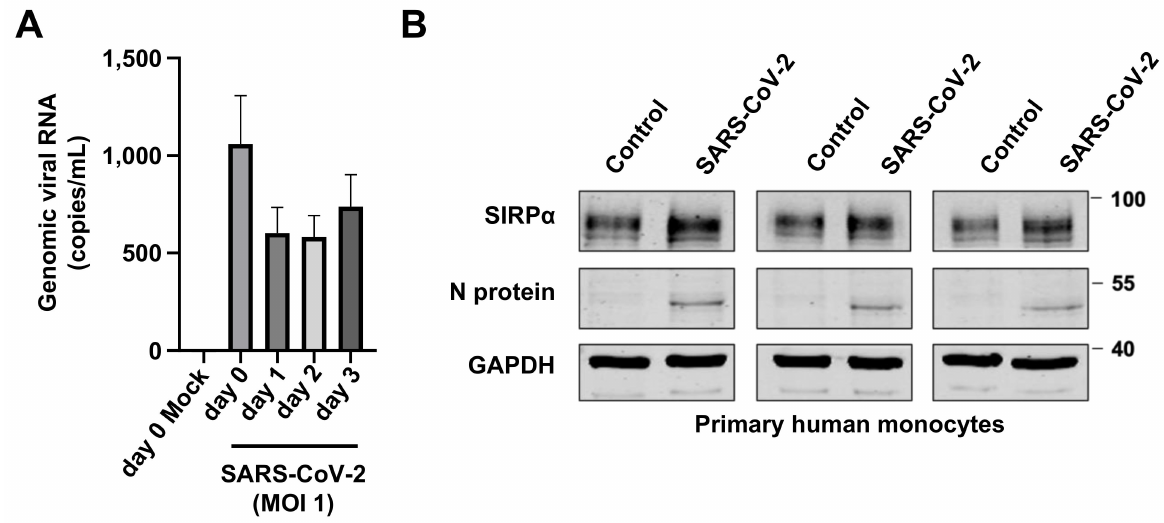
Figure 2. SARS-CoV-2 infection increases SIRP α in primary human monocytes. ( A ) SARS-CoV-2. The (MOI 1) infection of primary human monocytes does not result in the production of genomic viral RNA, as detected by PCR. ( B ) SARS-CoV-2 strain FFM7 (MOI 1)-infected primary human monocytes display enhanced SIRP α levels. Uncropped blots are provided in Figure S4. Quantification of the protein levels is provided in Figure